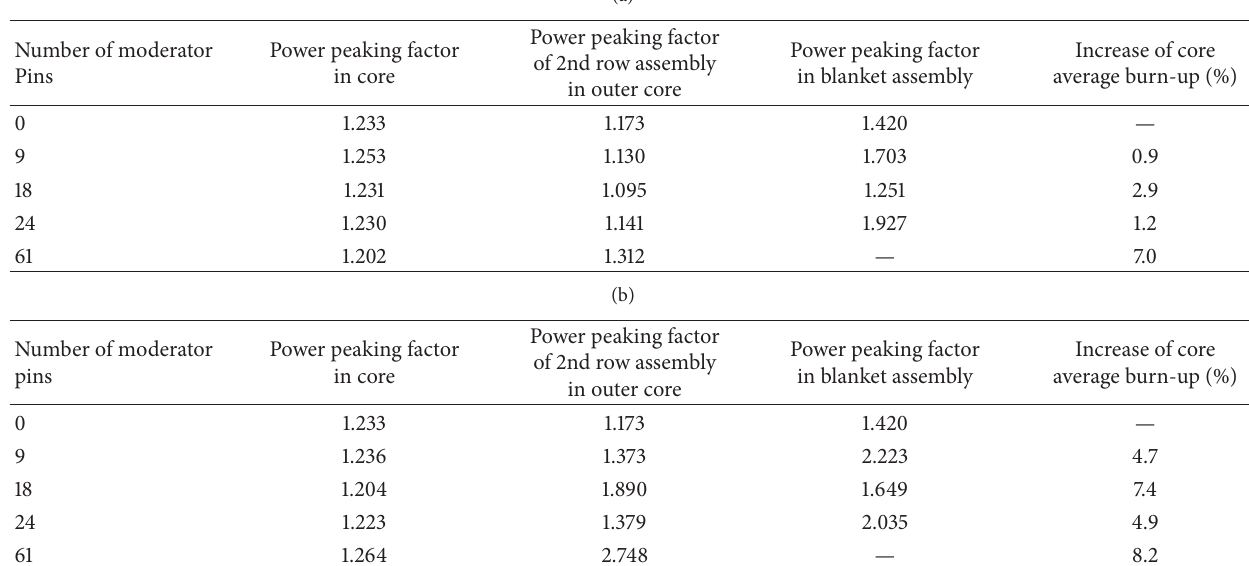
Table 3: (a)Dependence of coreperformances on thenumber ofZrD moderator pins. of ZrH 1.7